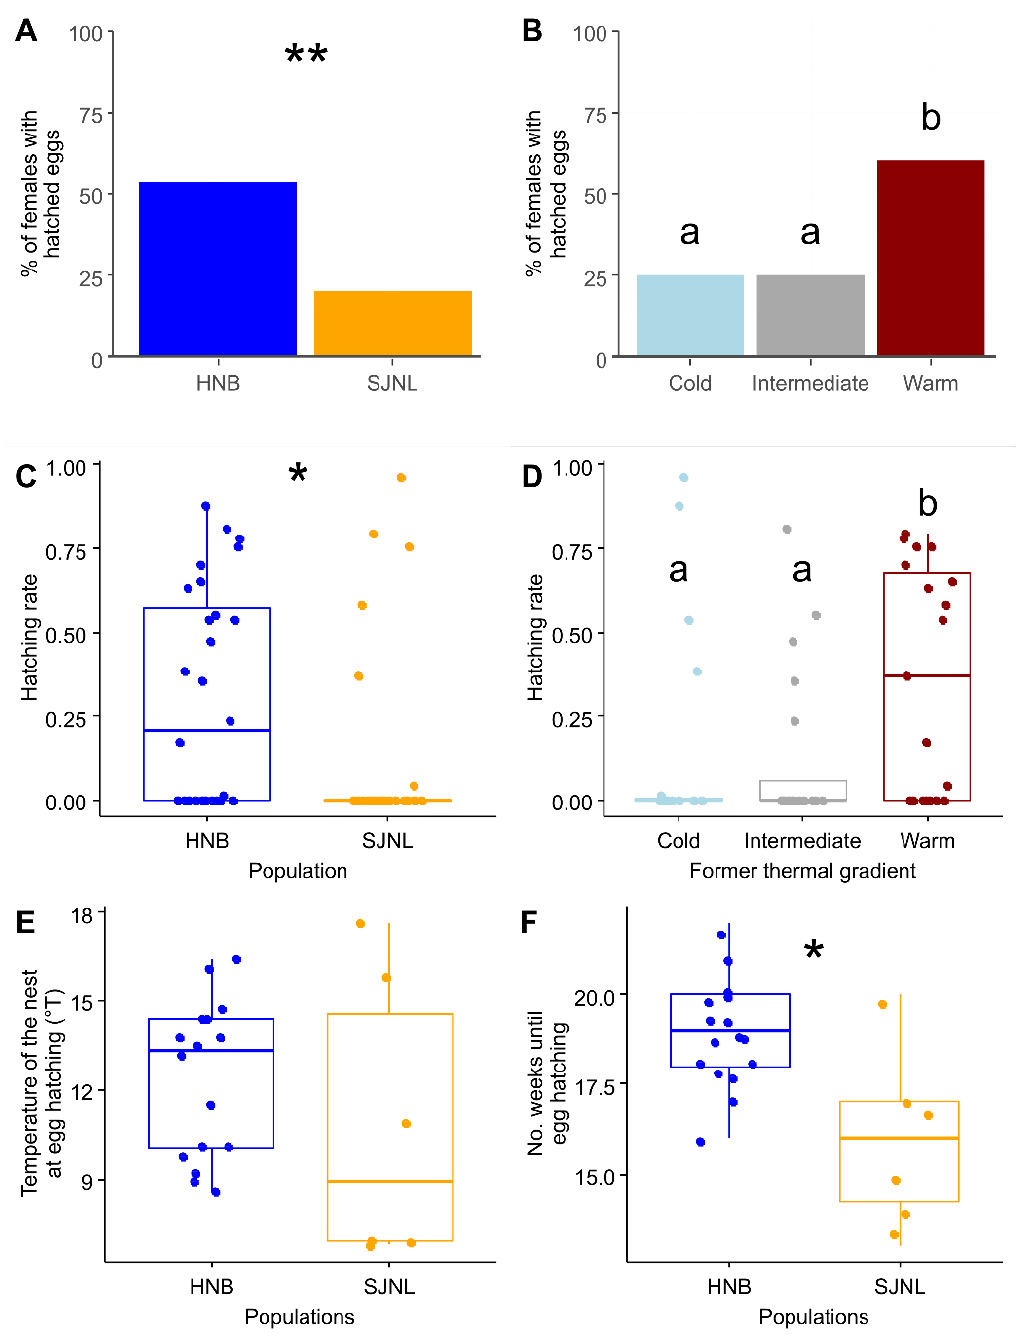
Figure 5 – Effect of population and temperature range on (A,B) the percentage of females with at least one hatched egg and (C,D) the egg hatching rate. Effect of population on the location of the eggs at the time of hatching (E) and the number of weeks between oviposition and egg hatching (F). Figures E and F involved females from the warmest range of temperature only, as their numbers were too limited in the other range of temperatures. Box plots depict median (middle bar) and interquartile range (light bar), with whiskers extending to 1.5 times the interquartile range and dots representing jittered experimental values. ns: P>0.05; *P<0.05; **P<0.01; . p = 0.07. Different letters indicate P<0.05. HNB: Harvey Station. SJNL: St